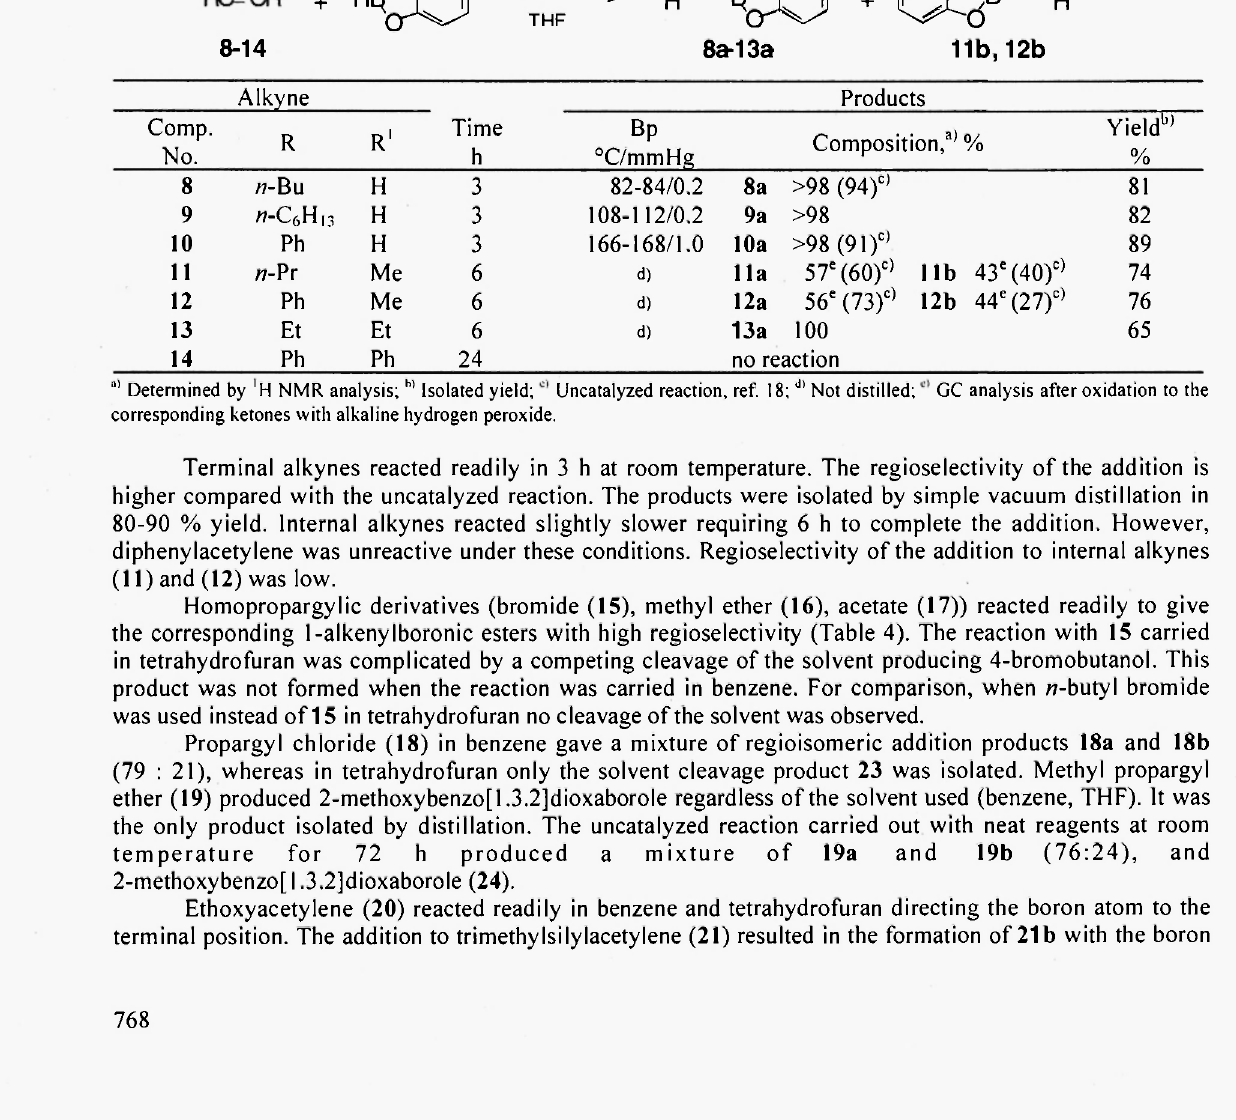
Table 3. Hydroboration of alkynes with catecholborane catalyzed by NiCI 2 (dppe) at room temperature in tetrahydrofuran NiCL(dppe) R x / R1 R x / R1 <o h>=<£Q • C O ^" +